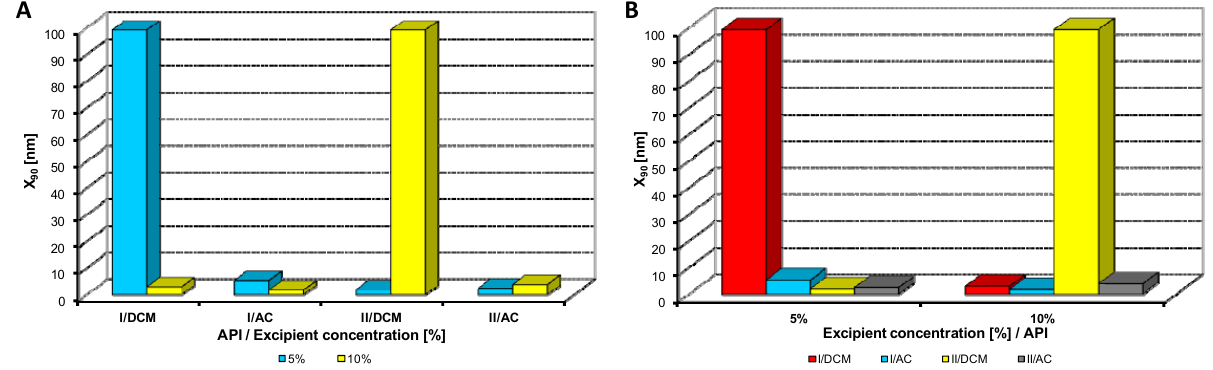
[nm]) of model APIs I , II on concentration [%] Figure 3. Dependence of particle size (x 90 of sodium dodecyl sulfate in dichloromethane (DCM) or acetone (AC). ( A ) Samples are grouped according to APIs; ( B ) samples are grouped according to excipient percentage. For clarity sake, the values on y-axis are only to 100